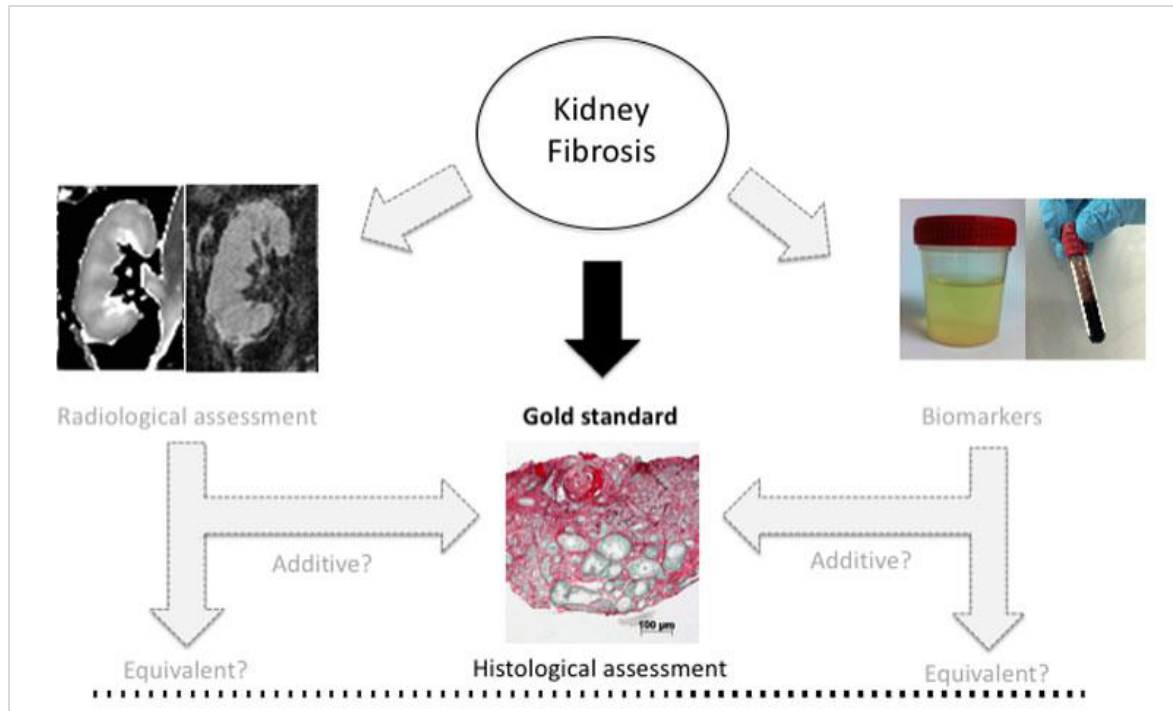
Figure 3: Kidney fibrosis is currently evaluated by histological assessment. Novel tools such as biomarkers or MRI are emerging. The place of these tools in the assessment process has yet to be determined as compared with the gold